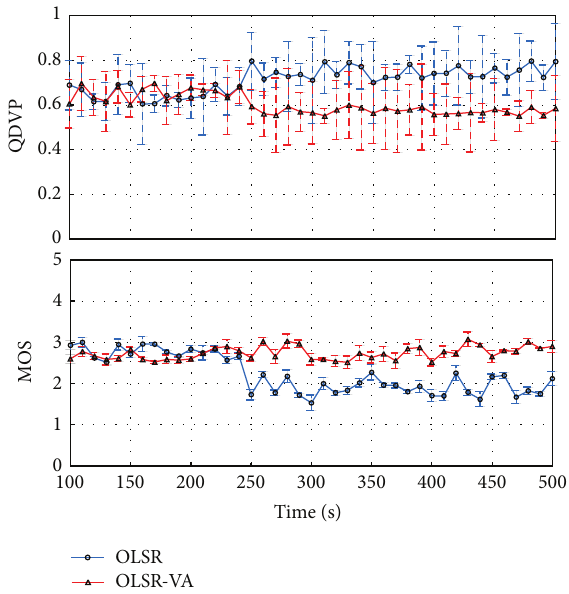
Figure 7: QDVP and MOS as a function of simulation time in scenario “2.”